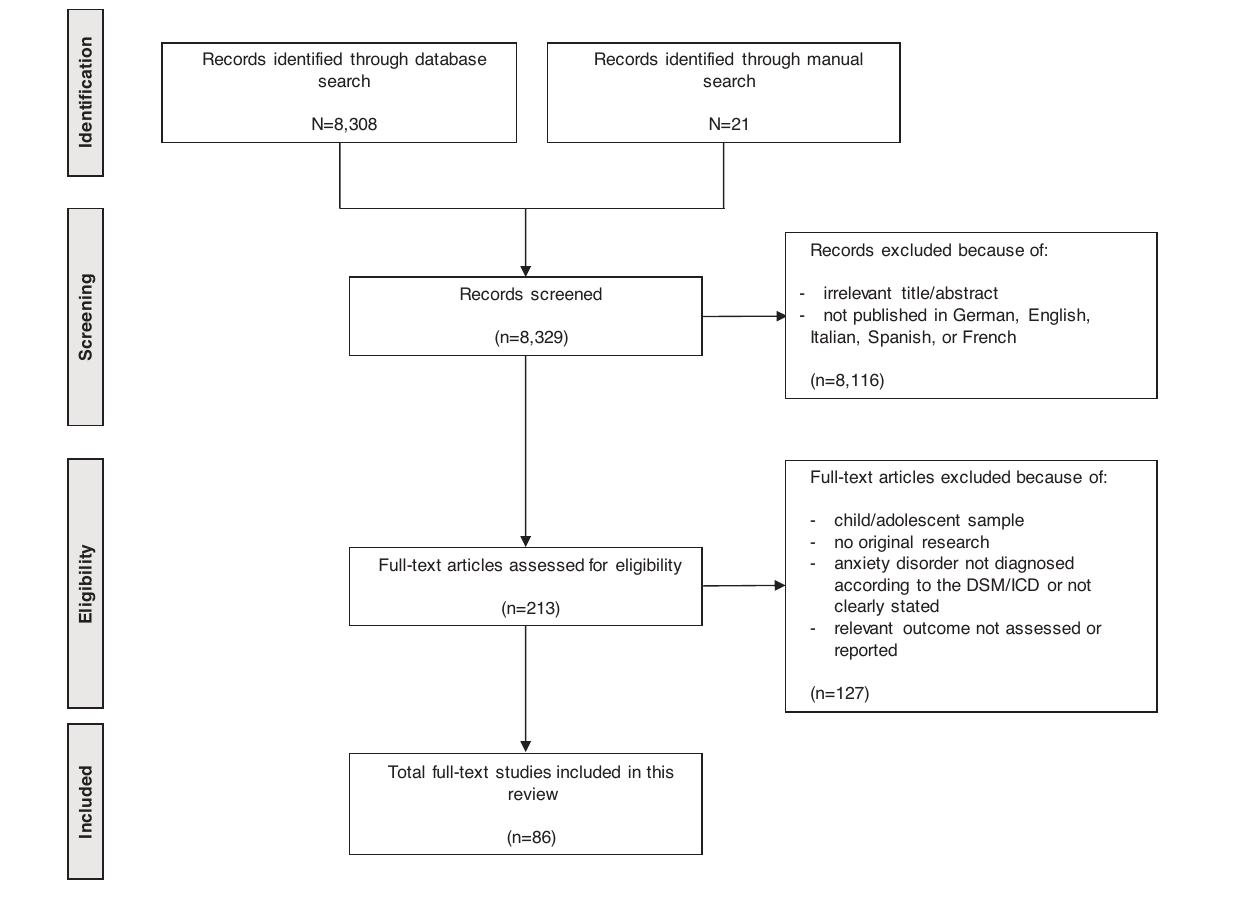
FIGURE 1 | Search